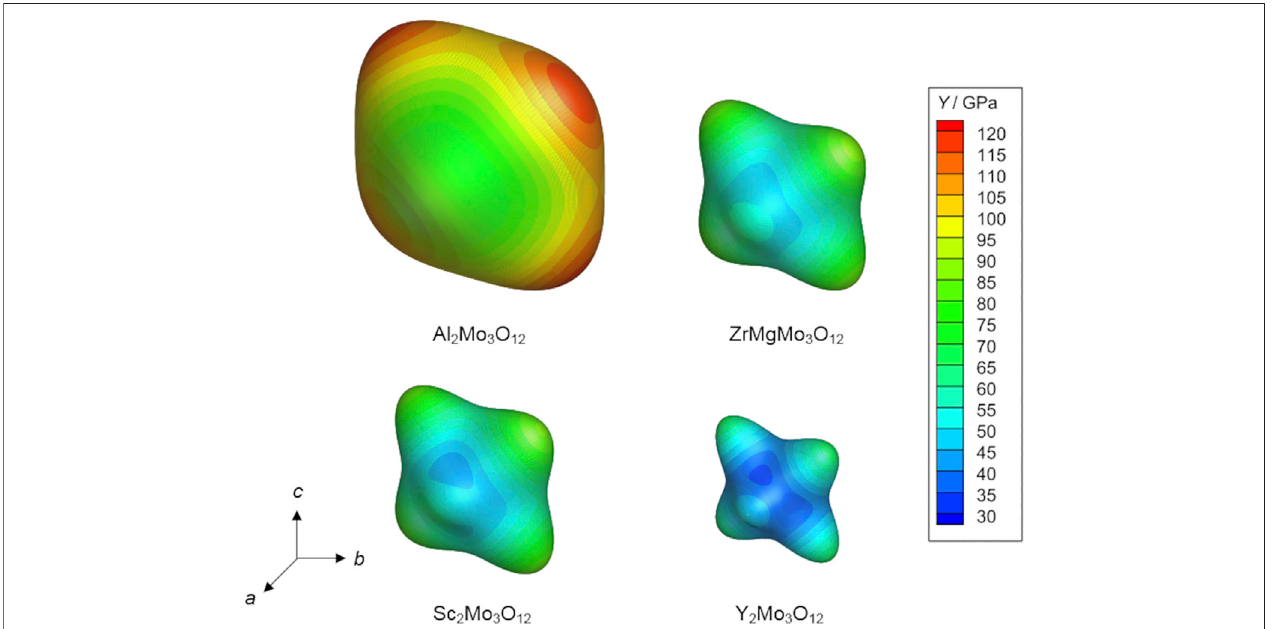
FIGURE 12 | Directional Young ’ s moduli of orthorhombic Al 2 Mo 3 O 12 , ZrMgMo 3 O 12 , Sc 2 Mo 3 O 12 , and Y 2 Mo 3 O 12 (Romao et al., 2014; Romao et al., 2016) in the Pbcn or P 2 1 nb setting, shown as contour plots generated using the nanoHUB Anisotropy Calculator – 3D Visualization Toolkit (Zuluaga et al., 2014). Adapted from Romao et al. (2016).